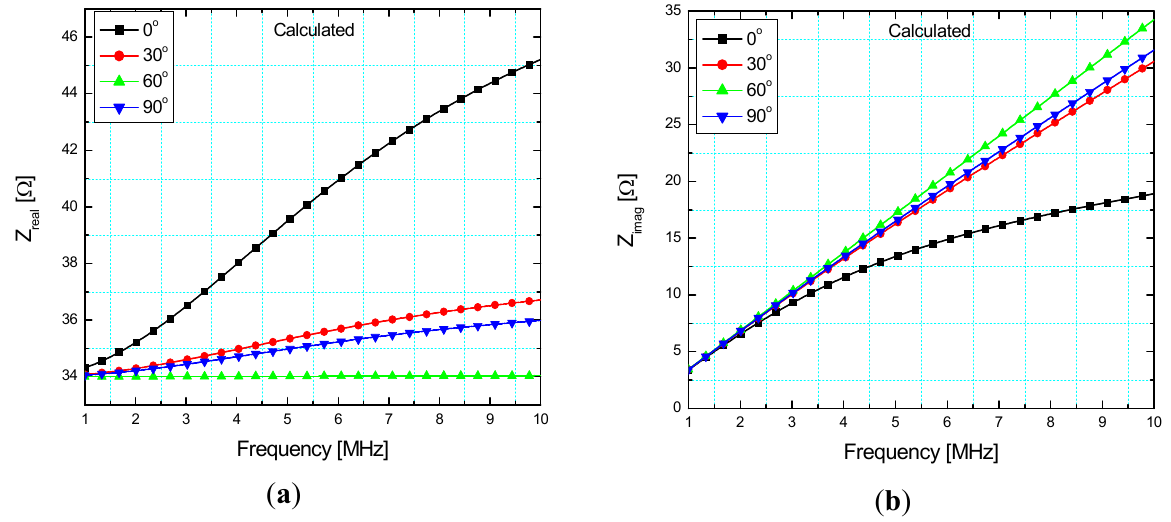
Figure 4. Calculated ( a ) real part– Z with the short circuit at the rotor depending on frequency and angular